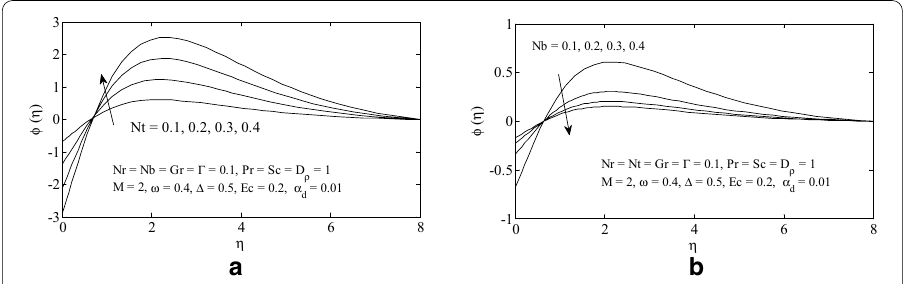
Fig. 8 a , b Impact of Nt and Nb on concentration profile φ(η)